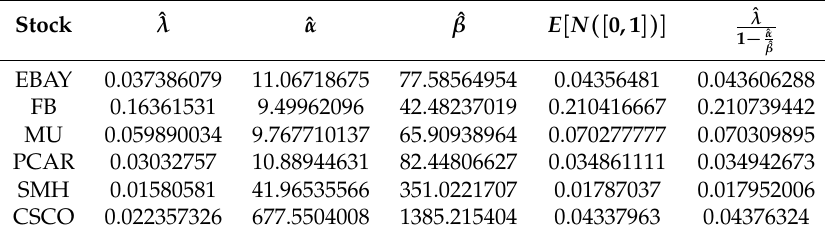
Table 11. Calibration Result of Hawkes Process.